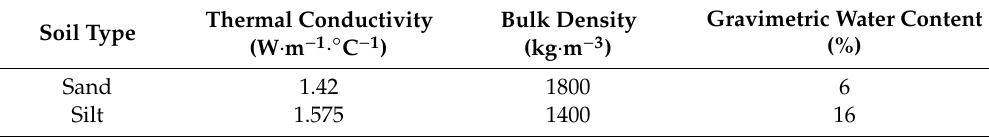
Table 3. The thermal parameters for the di ff erent soil